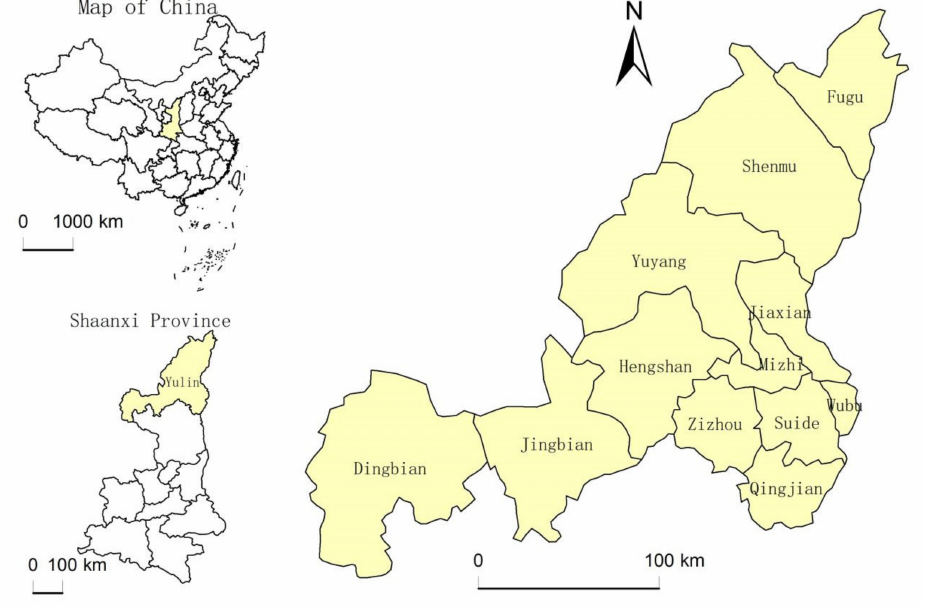
Figure 1. Location map of the study